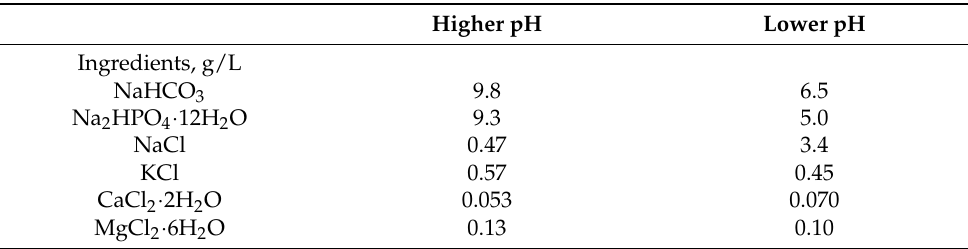
Table 2. Composition of the two buffer solutions infused into the continuous cultures to obtain higher or lower pH in the culture